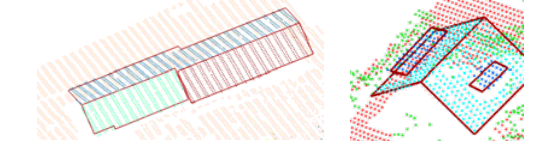
Figure 9: Maintaining the correct boundary shape (left) and Roof models with dormers, after gap filling (right)